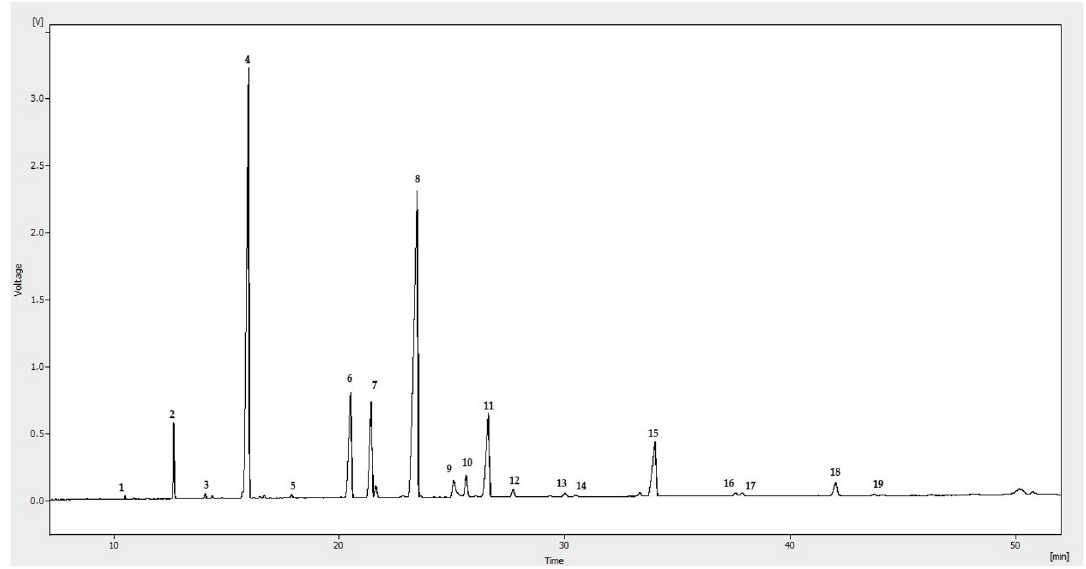
Figure 6. Typical chromatogram of fatty acids profile in co ff ee silverskin fat (1—C12:0;